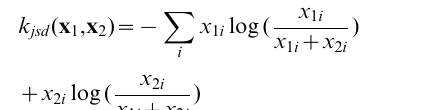
Figure 7. Illustration of the user interface.